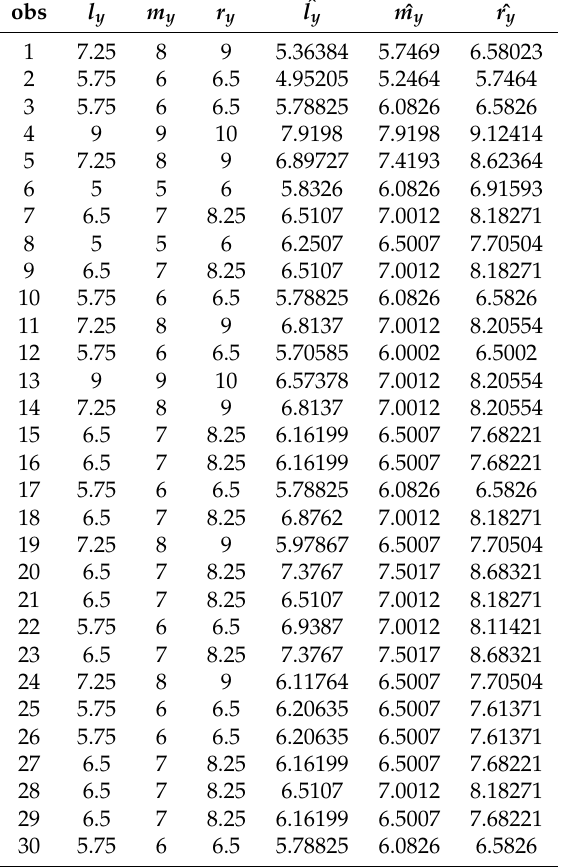
Table 4. The final prediction results of the dependent variable.